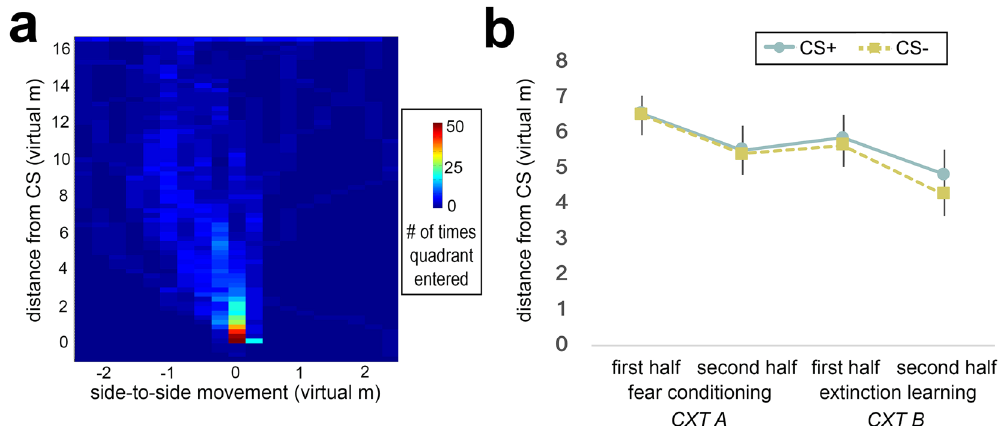
Figure 4. Approach/avoidant behavioral tendencies during fear conditioning and extinction learning in children. ( a ) Heatmap of movement in the virtual environment for an example participant during fear conditioning. Participant is placed at the starting point at the bottom of the image (x = 0, y = 0), and is instructed to move towards the conditioned stimulus (CS) at the top of the image. Warm and cool colors indicate number of times participant visited a quadrant. Distance from the CS (y-axis), as well as side-to-side distance traveled (x-axis), are quantified for each CS type (CS + , CS − ) as a measure of approach/avoidance behavioral action tendencies and used in statistical analyses. Of note, for display purposes the frequency value of the origin was censored to consider periods when the participant was placed into the origin. ( b ) Participants approached both CS’s over the course of fear conditioning and extinction learning. CS + and CS − refer to the avatar (virtual person) that is paired and unpaired with the US (white noise burst), respectively. Error bars represent standard error. Abbreviations: CS, conditioned stimulus; US, unconditioned